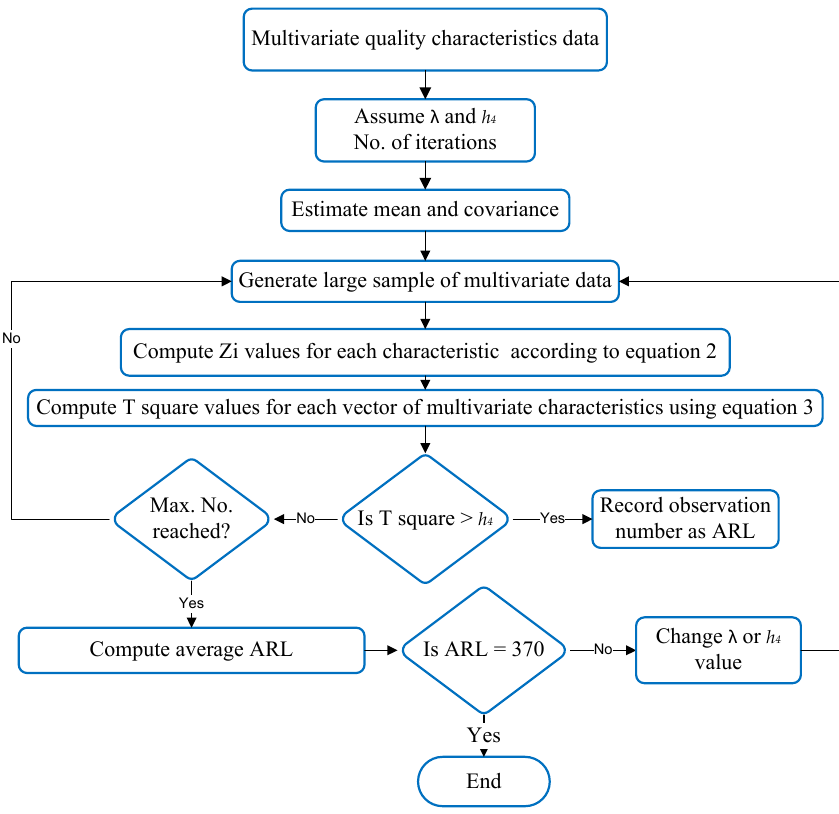
Figure 6. Algorithm for optimizing MEWMA parameters.